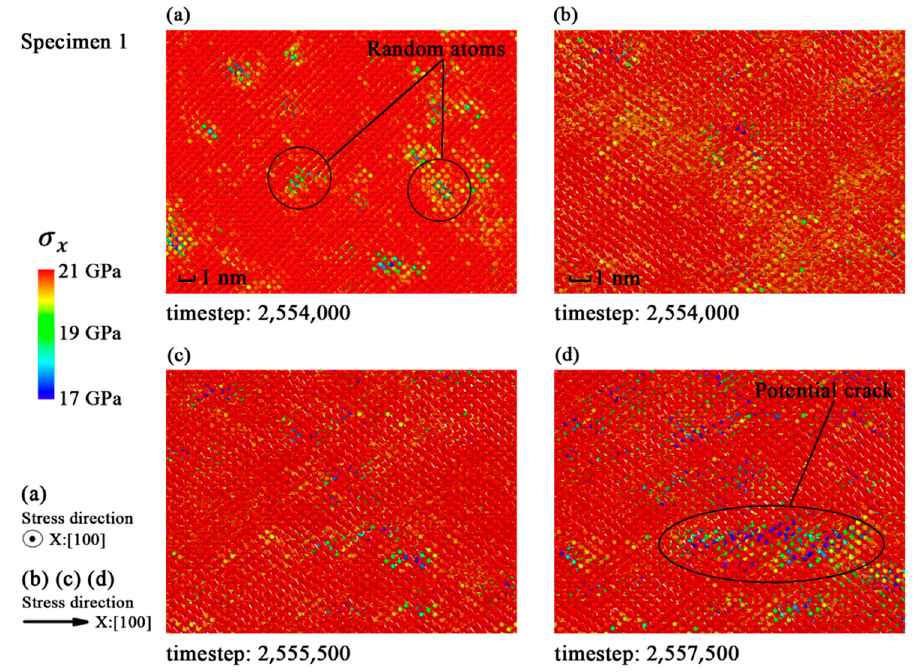
Figure 3. Distribution of σ x in specimen 1 before fracture: ( a ) Snapshot at timestep 2,554,000; ( b ) snapshot at timestep 2,554,000; ( c ) snapshot at timestep 2,555,500; ( d ) snapshot at timestep 2,557,500.